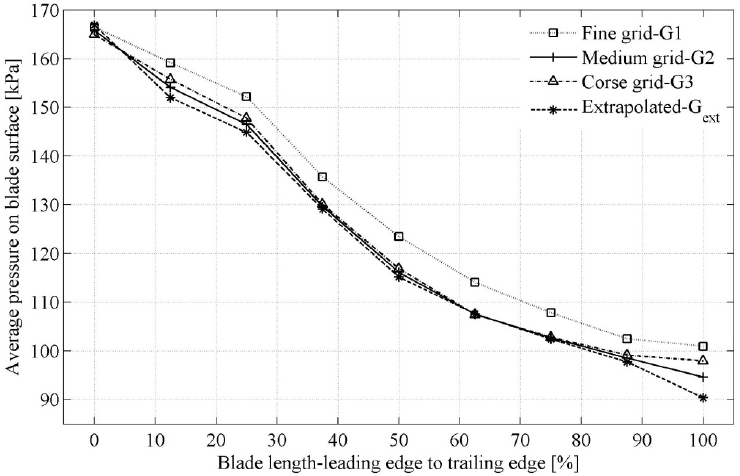
Figure 8. Pressure distribution on the blade for three grid densities and extrapolated pressure [5].